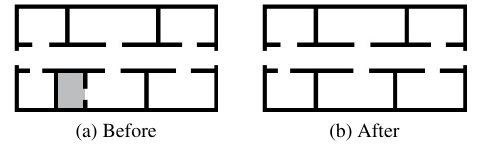
Figure 14. Indoor structure SLODs. Data source: Autodesk.